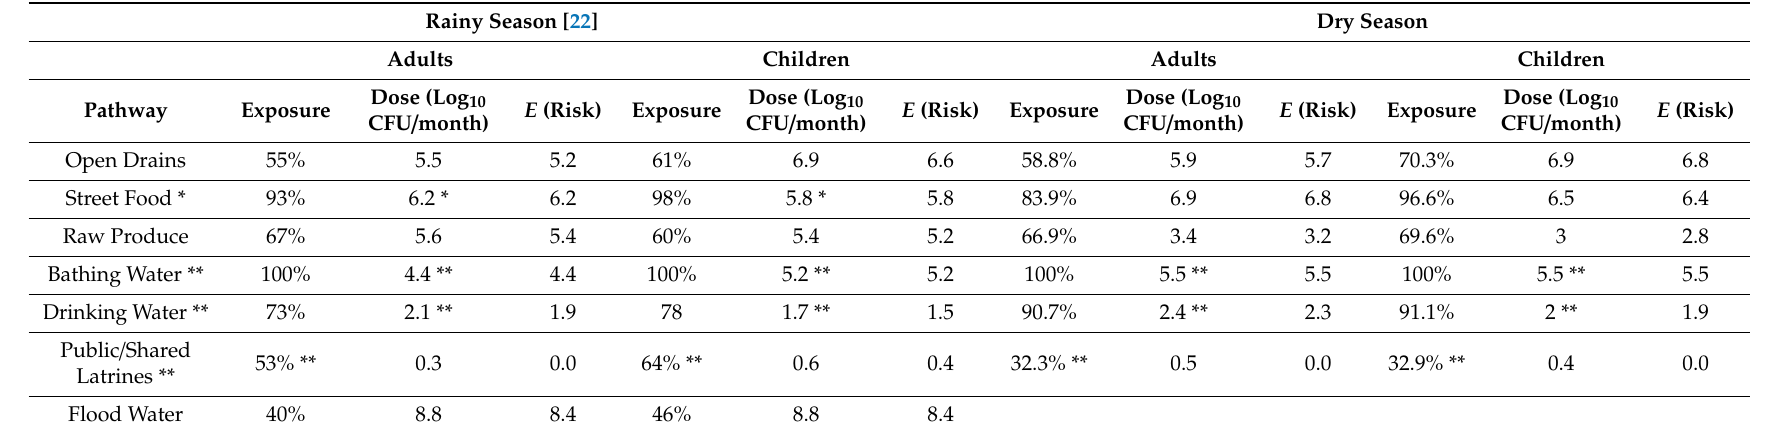
Table 5. Risk profiles generated by the SaniPath tool, showing percentage of adults and children exposed, dose per month (Log 10 CFU / Month E. coli), and E, which represents overall risk